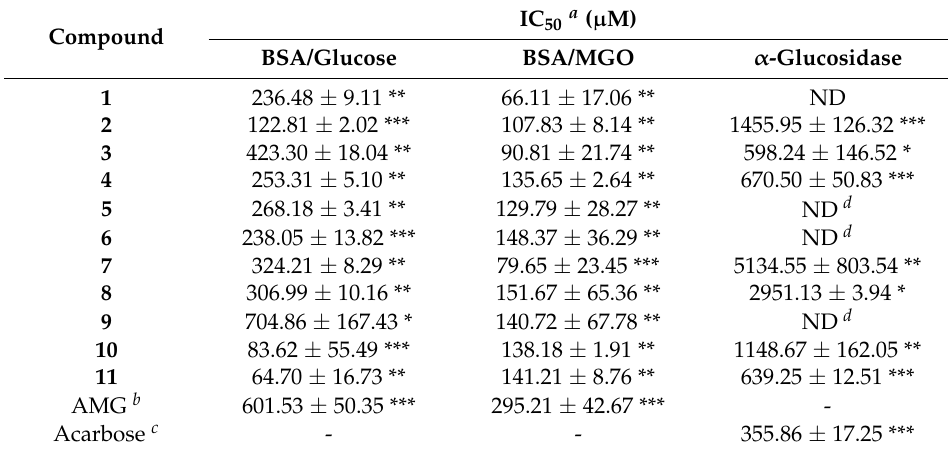
Figure 2. Chromatograms of ( A ) standards mixture and ( B ) T. coreanum ext. Table 2. Identification of compounds 1 – 11 in T. coreanum by UHPLC-ESI/LTQ-Orbitrap-HRMS analysis.